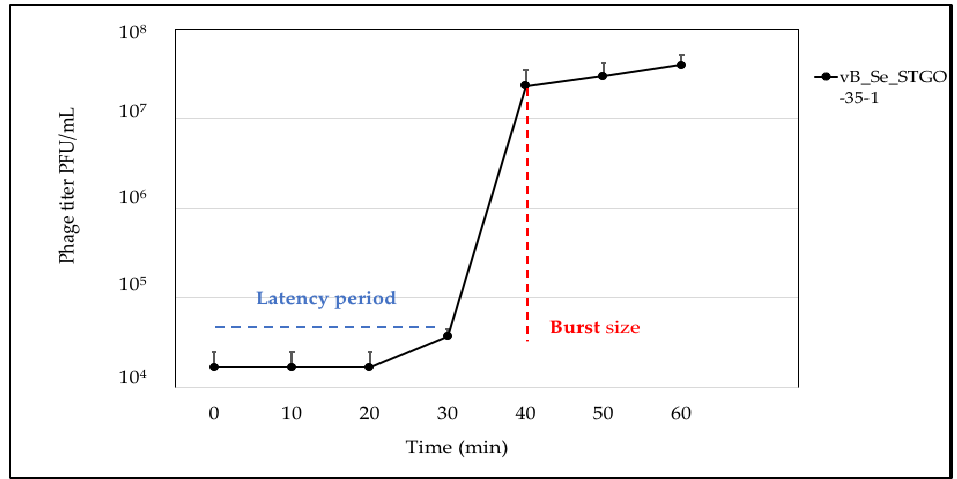
Figure 1. One-step growth curve of STGO-35-1. The phage concentration (PFU/mL) was followed over time after infection of Salmonella with phage STGO-35-1. A latency period (in blue) of 30 min (±10 min) and a burst size (in red) of 122 (±10 PFU/mL) can be observed. Transduction efficiencies were tested to rule out whether this phage could transduce resistance gene to a significant level, which would have been a key obstacle against its use as a biocontrol agent. The transduction efficiency studies demonstrated that STGO-35-1 is not capable of transducing an antimicrobial resistance gene, with tested volumes of 1, 5, and 20 µL of the phage at a concentration of 10 8 PFU/mL (Table S2). As for the positive control (phage P22 HT int), antibiotic-resistant colonies ( km r ) were observed, which in- creased in number along with the volume of phage transducer used. The frequencies of transduction did vary for the control phage from 3 × 10 −5 to 2 × 10 −6 PFU/CFU. While we used an MOI that could have missed some level of transduction, and the control was a